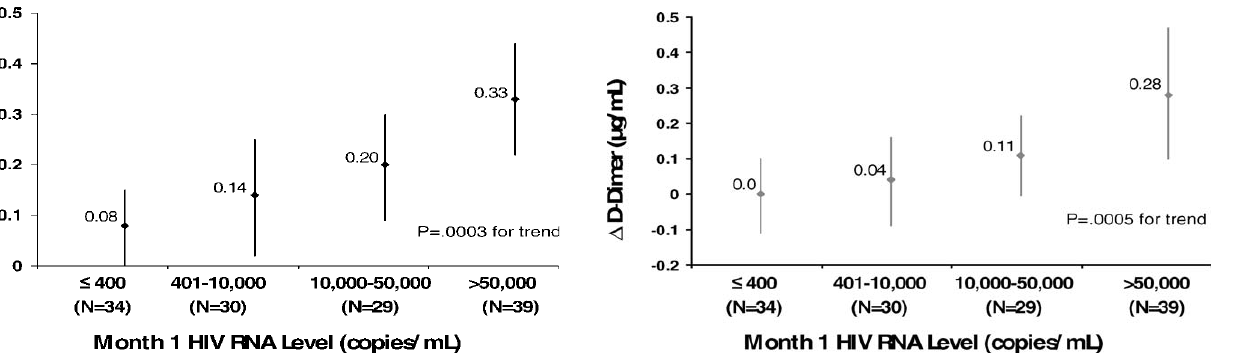
Figure 4. Change in Log 10 D-dimer ( l g/ml) from Baseline to 1 mo According to HIV-RNA Level at 1 mo for Participants in the Drug Conservation (DC) Group (CD4 þ Guided Intermittent ART) with an HIV- RNA level 400 Copies/ml or less at